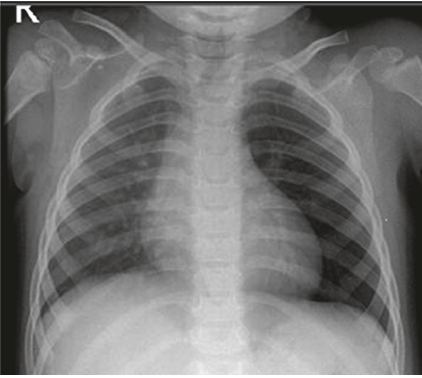
Figure 1: Chest X-ray showing hyperinflation on the left side.